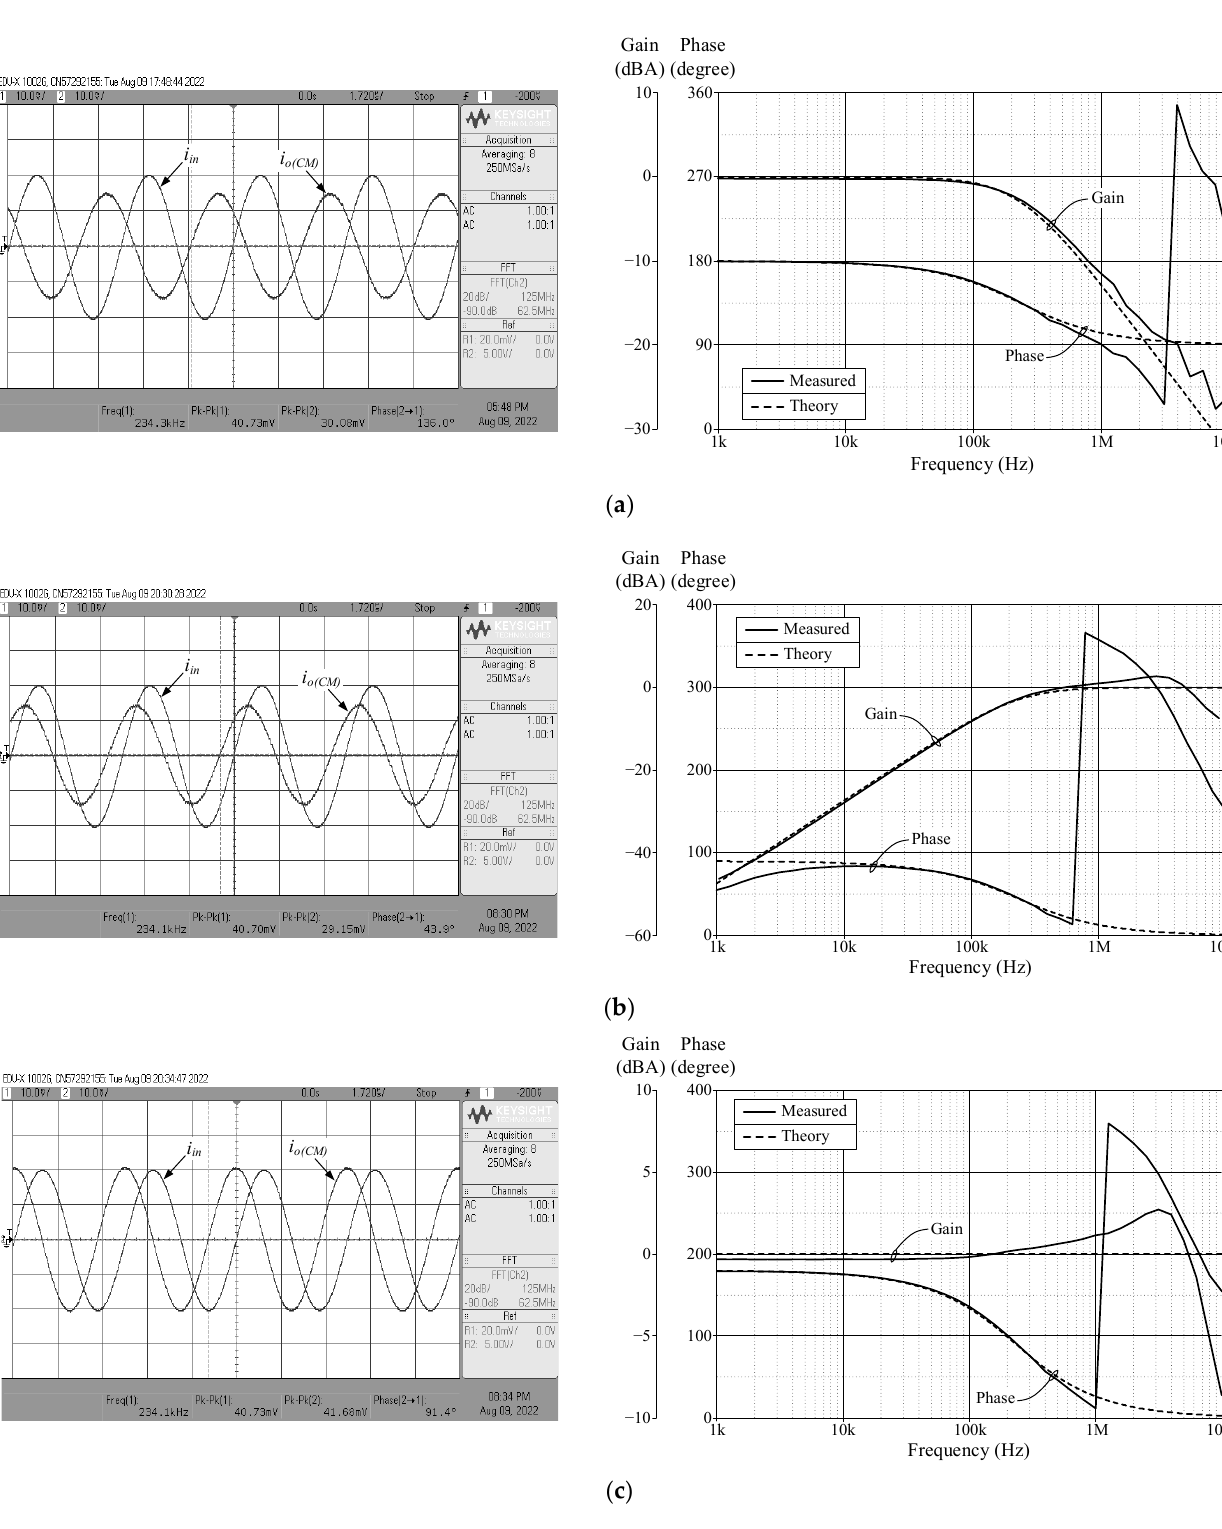
Figure 15. Measured time and frequency responses of the proposed CM filter: ( a ) LP; ( b ) HP; and ( c ) AP.